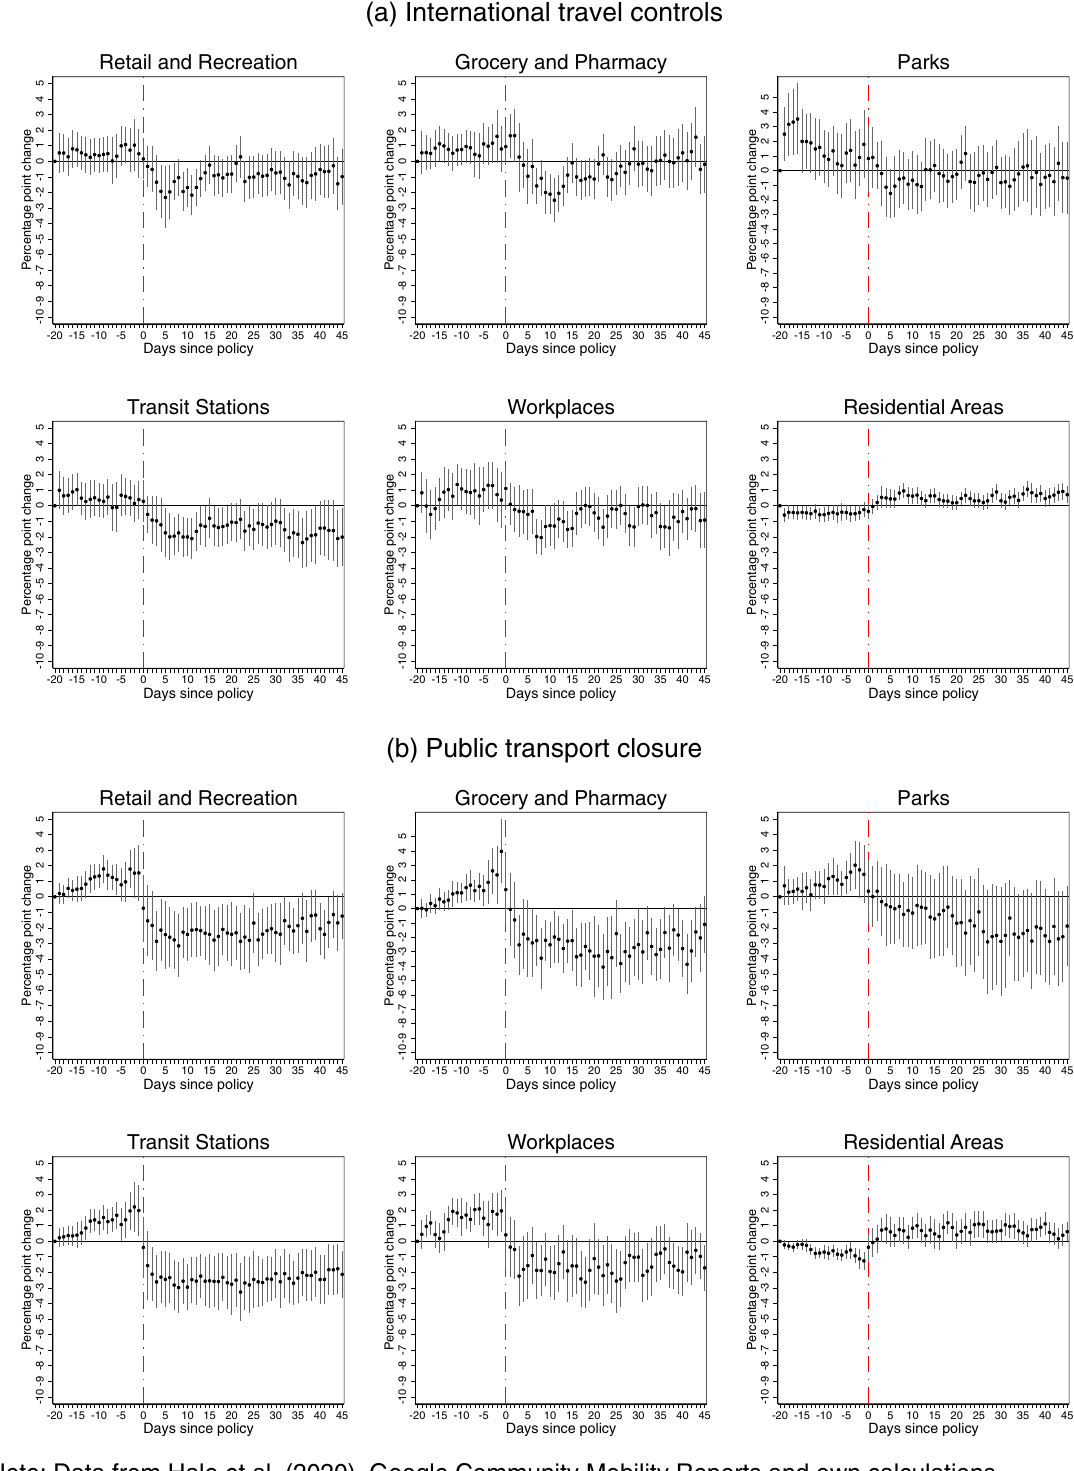
Figure 2. Effects of international travel controls (panel a ) and closure of public transportation (panel b ) on Google mobility